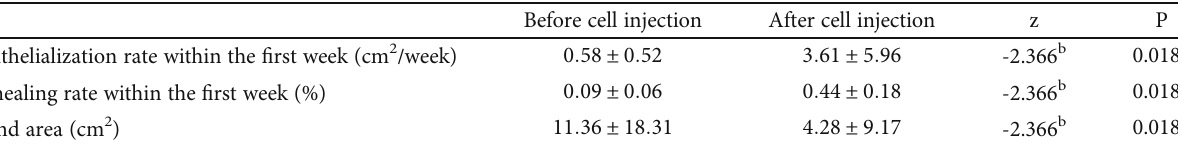
The reepithelialization rate and healing rate of wounds given cell injection were signi fi cantly faster than before cell injection within the fi rst week ( mean ± SD ), ∗ P < 0 : 05 vs. wound before cell injection. b Rank sum